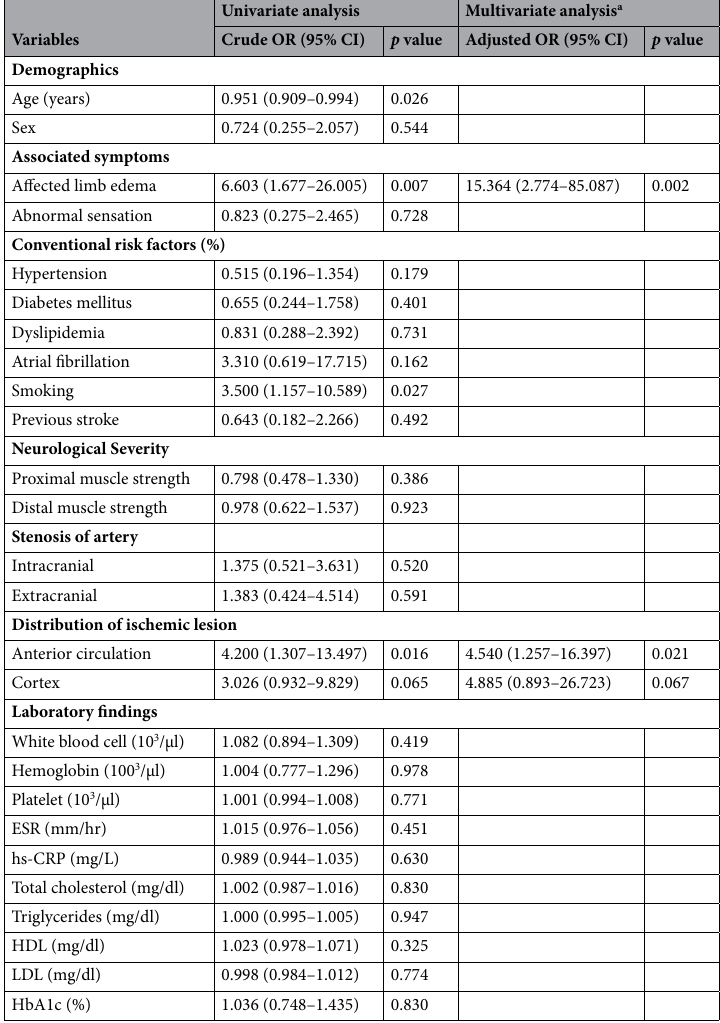
Table 3. Logistic regression analysis according to Raynaud scan results. OR odds ratio, CI confidence interval, ESR erythrocyte sedimentation rate, hs-CRP high sensitivity C-reactive protein, HDL high density lipoprotein, LDL low density lipoprotein, HbA1c hemoglobin A1c. a Adjusted for age, smoking, affected limb edema, anterior circulation, and